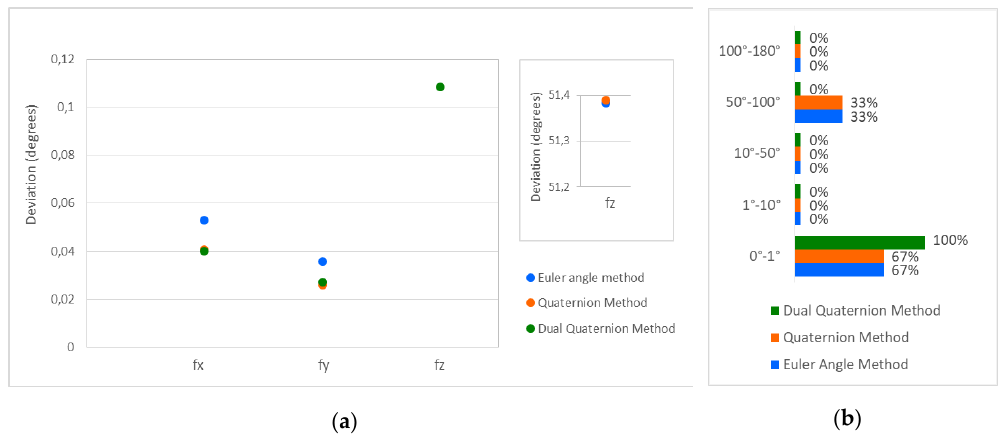
Figure 11. ( a ) Deviations in degrees for rotation angles per axis for all methods. ( b ) Histogram of deviations for rotation angles per axis for all methods.